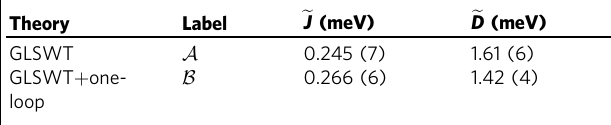
Table 1 Parameter sets of GLSWT and GLSWT + one-loop